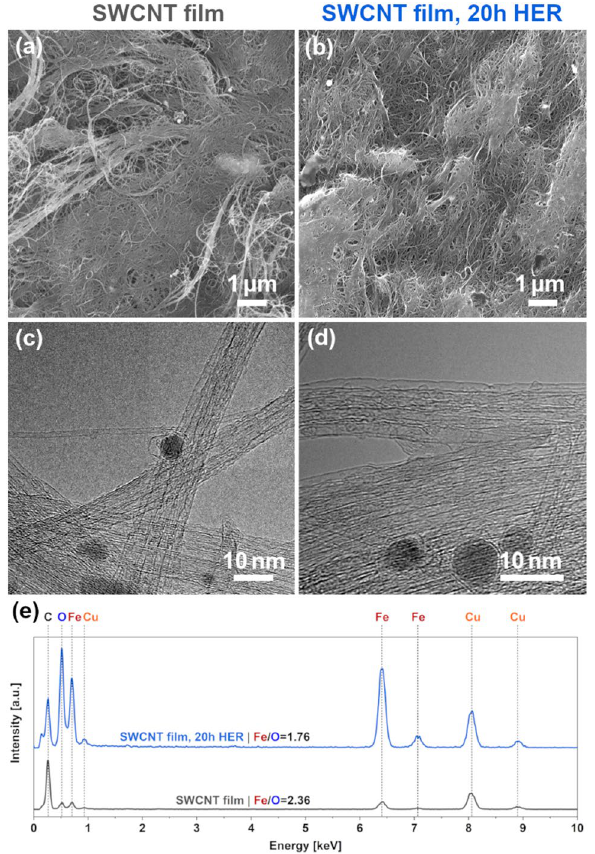
Figure 3. Characterization of SWCNT films (freshly annealed and after 20 h of HER) by ( a , b ) SEM, ( c , d ) TEM, and ( e ) EDX coupled with TEM (normalized to the maximum of the intensity of carbon